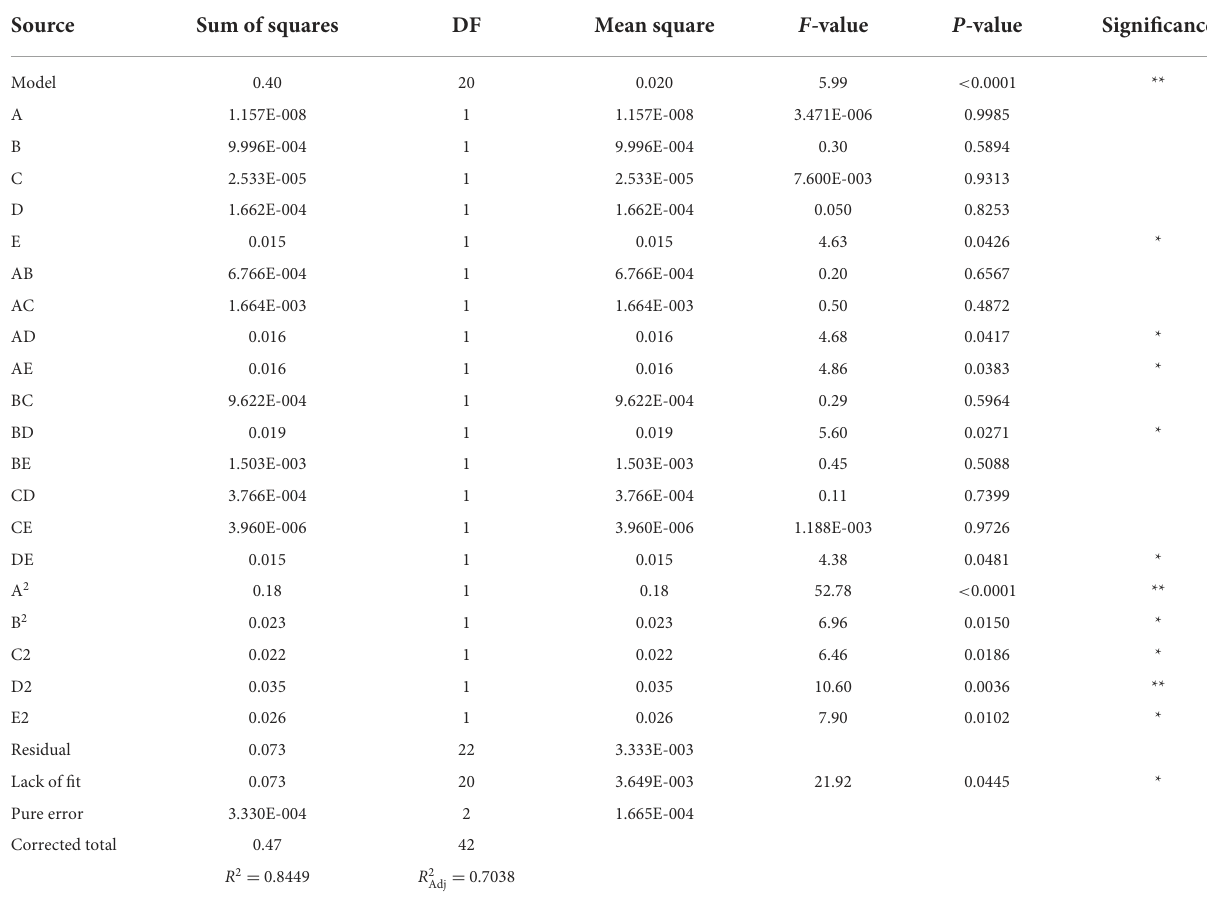
TABLE 2 Box-Behnken design for the selected factors and analysis of variance for the fitted quadratic polynomial model. Source Sum of squares DF Mean square F -value P -value Significance Model